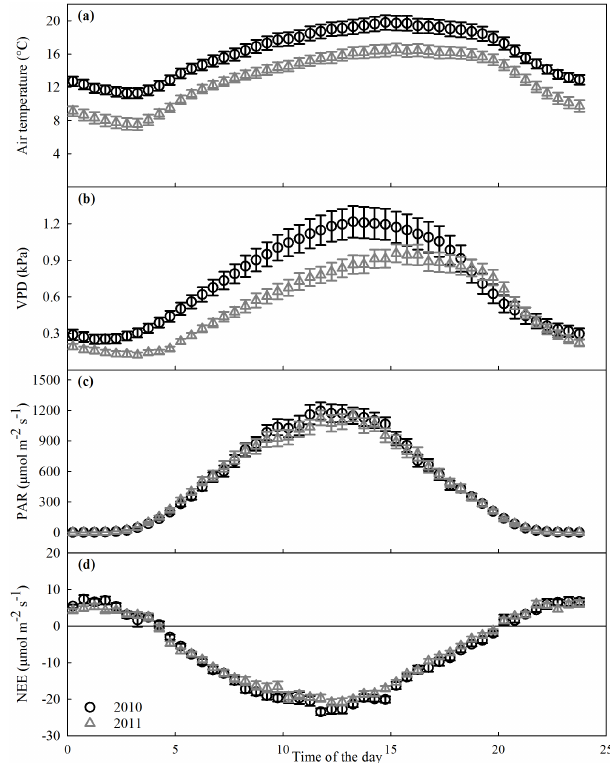
Figure 4. Mean diurnal variations in June 2010 (open grey tri- angles) and 2011 (open black circles). (a) Air temperature ( ◦ C). (b) Vapour pressure deficit (VPD, kPa). (c) Photosynthetically ac- tive radiation (PAR, µmolm − 2 s − 1 ) . (d) Net ecosystem CO 2 ex- change (NEE, µmolm − 2 s − 1 ) . Data are half-hour means with stan- dard